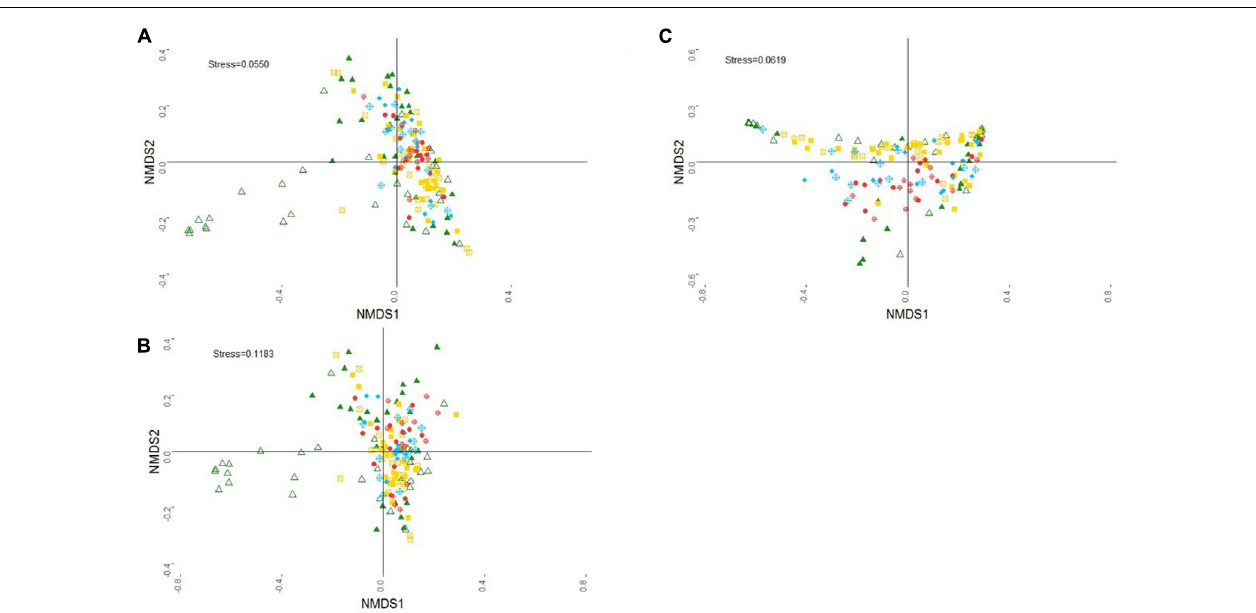
FIGURE 2 | Non-metric multidimensional scaling (NMDS) plot of rumen (A) archaeal, (B) bacterial, and (C) protozoal community structure. All samples across week are represented: 8 week-C (green shaded triangle), 8 week-T (green open triangle), 14 week-C (yellow shaded square), 14 week-T (yellow open square), 20 week-C1–C2 (red shaded circle), 20 week-T1–C2 (red open circle), 20 week-C1–T2 (blue shaded diamond), 20 wk-T1–T2 (blue open diamond).